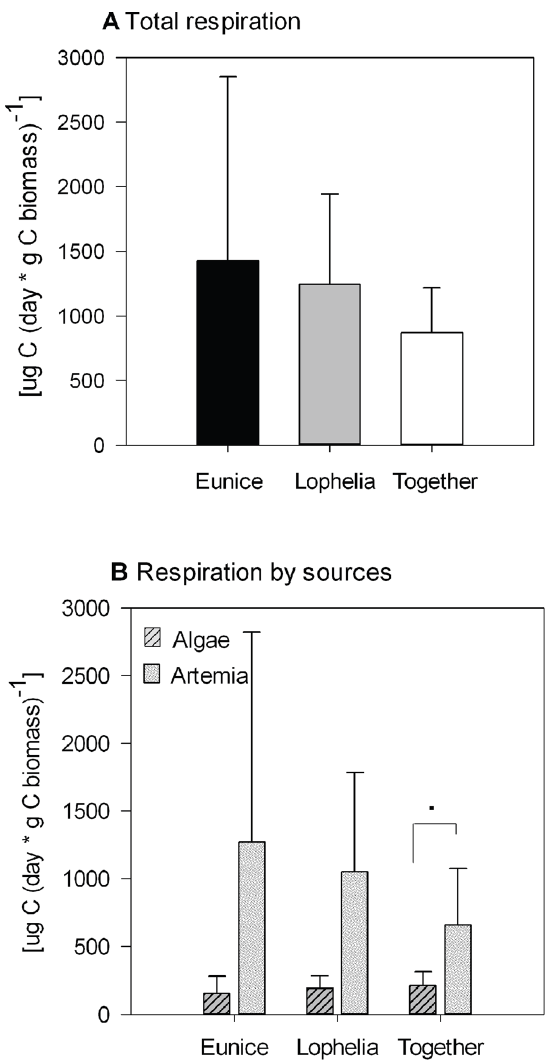
Figure 4. Calcification by L. pertusa. a) Total calcification, b) calcification separated by food substrate (algae, Artemia ). L. pertusa was kept with and without E. norvegica ; statistical significance between treatments is indicated as followed: ** p , 0.009, * p , 0.05, ? 0.05 , p , 0.06. The bars in each figure represent average 6 SD.